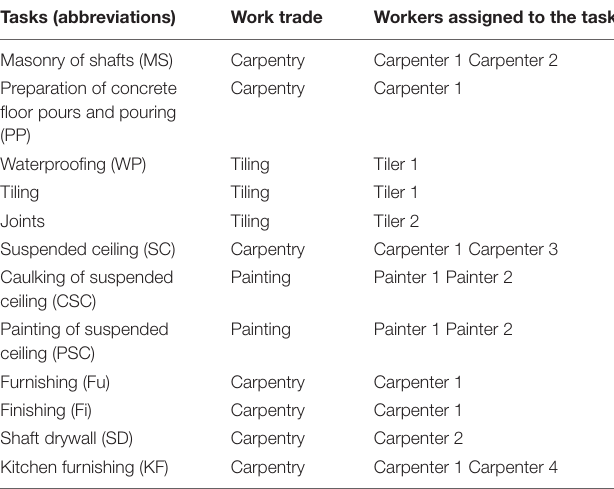
TABLE 2 | Summary of tracked workers in the selected case